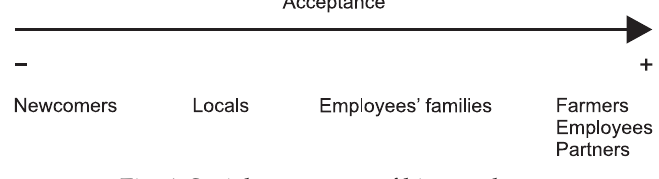
Fig. 4. Social acceptance of biogas